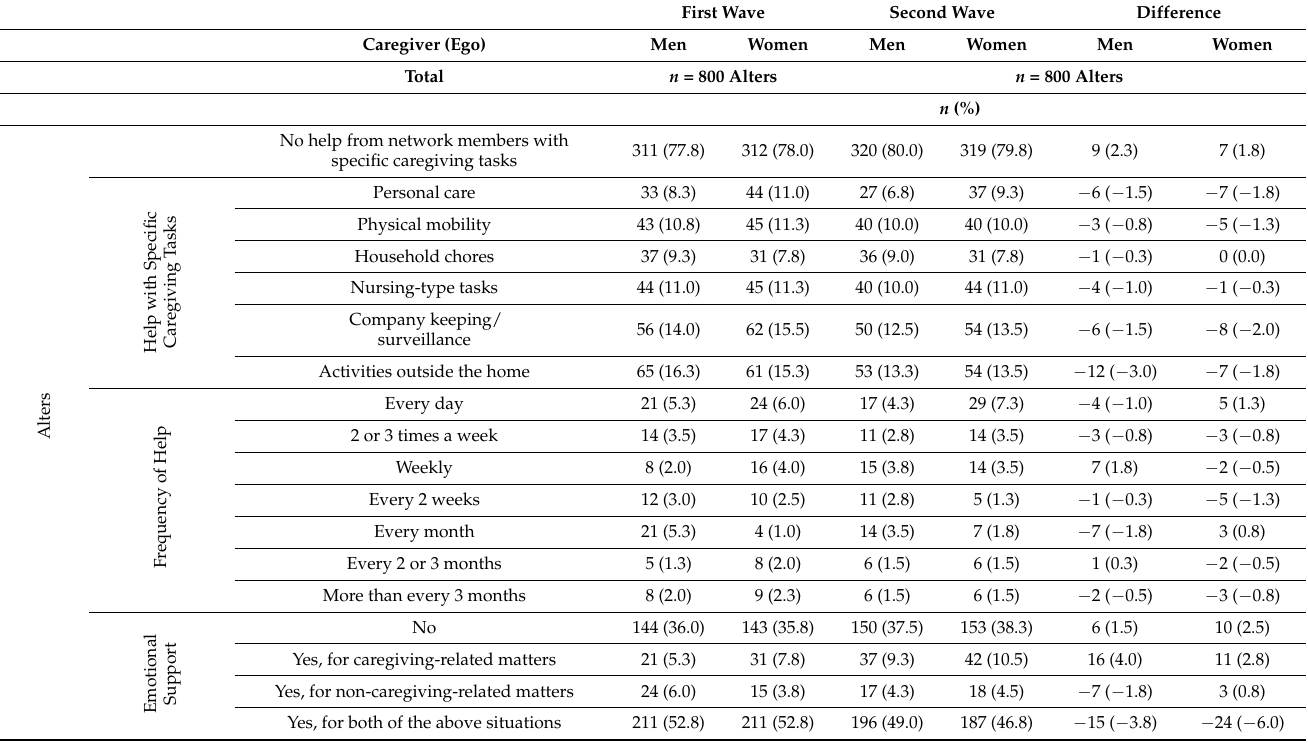
Table 2. Changes in support according to caregiver